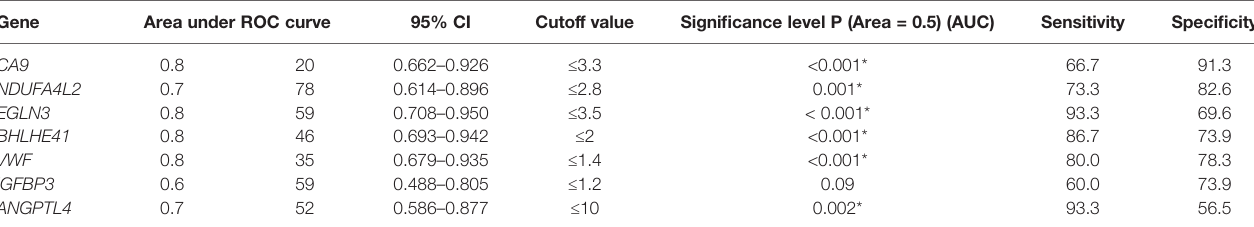
TABLE 6 | Relationship between gene expression and survival by comparing groups of patients living less and more than 3.5 years using ROC analysis.